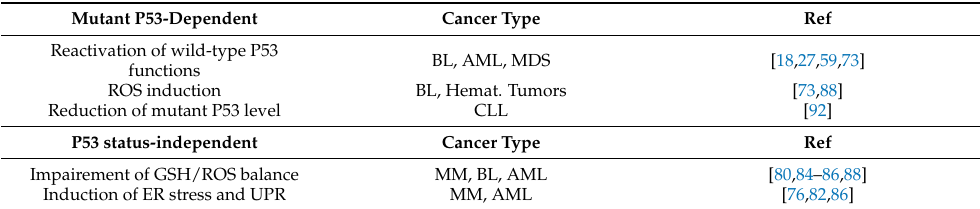
Table 1. Mutant P53-dependent and -independent activities of PRIMA-1/APR246 reported in hematological tumor